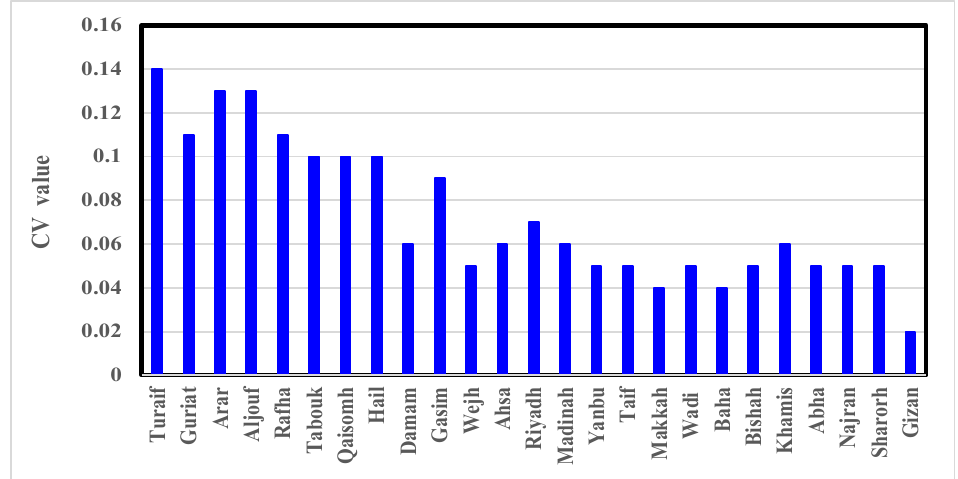
Figure 3. The coefficient of variation of Winter Air Temperatures for Saudi Arabia stations. The stations are arranged from north to south .